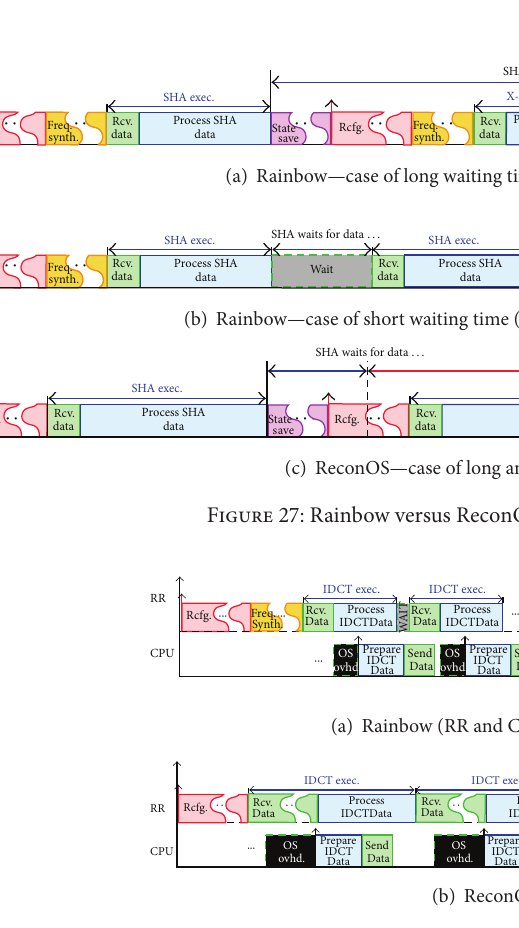
Figure 28: Rainbow versus ReconOS (periodic execution